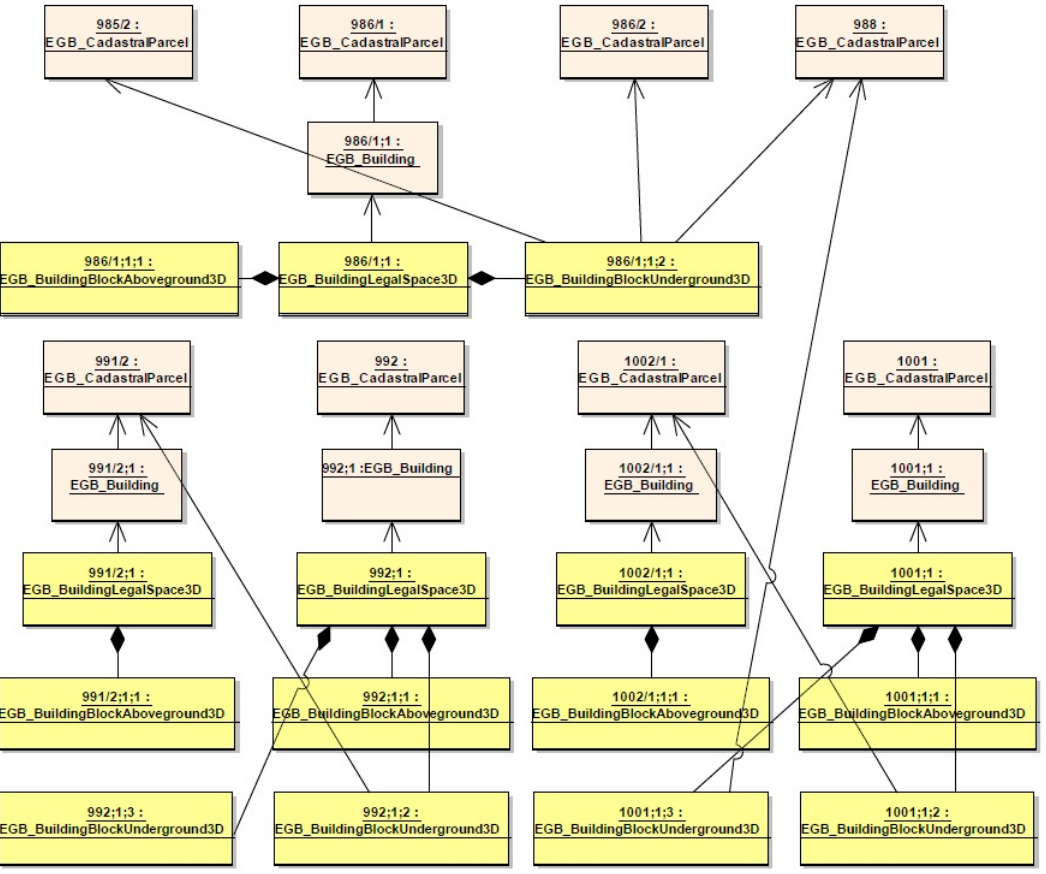
Figure 22. Relationships between classes representing the Underground Tourist Route objects, buildings (and related objects), and cadastral parcels.